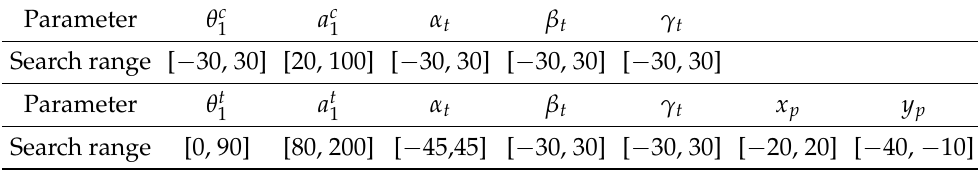
Table 6. Search ranges for the DH